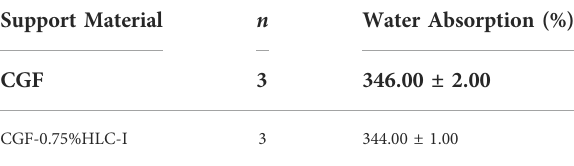
TABLE 1 Comparison of hydroscopicity test between CGF membrane and CGF-0.75% HLC-I composite bio fi lm ( ‾ X ±